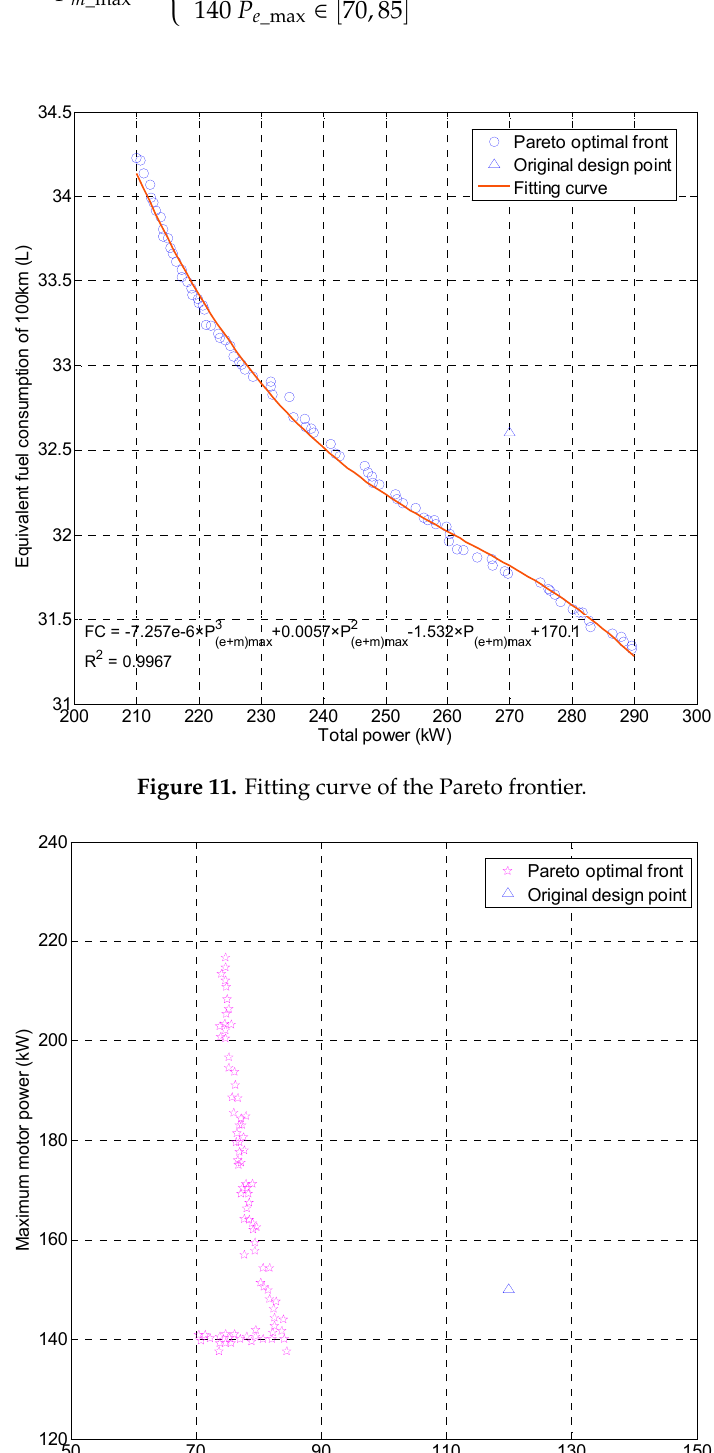
Figure 12. Design variable distribution of multi-objective optimization results.